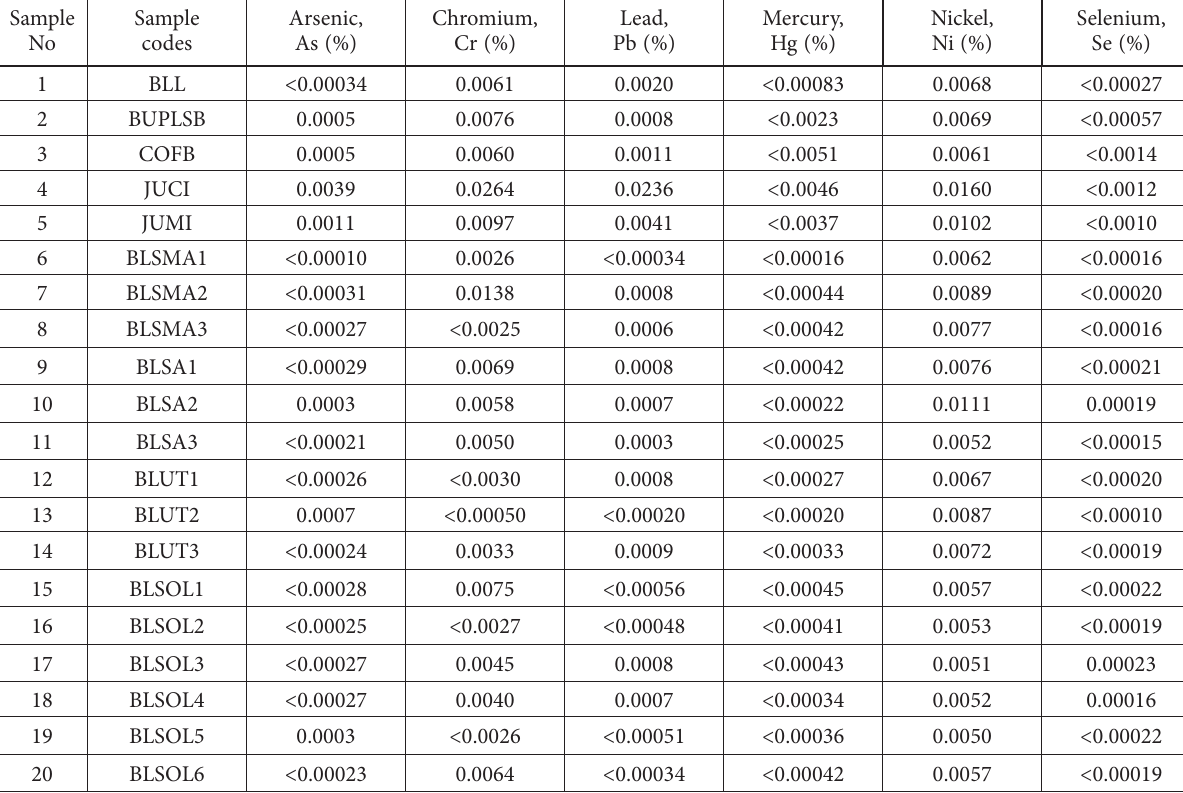
Table 4. Concentrations of heavy metals (% by weight) in ash samples of plant tissues